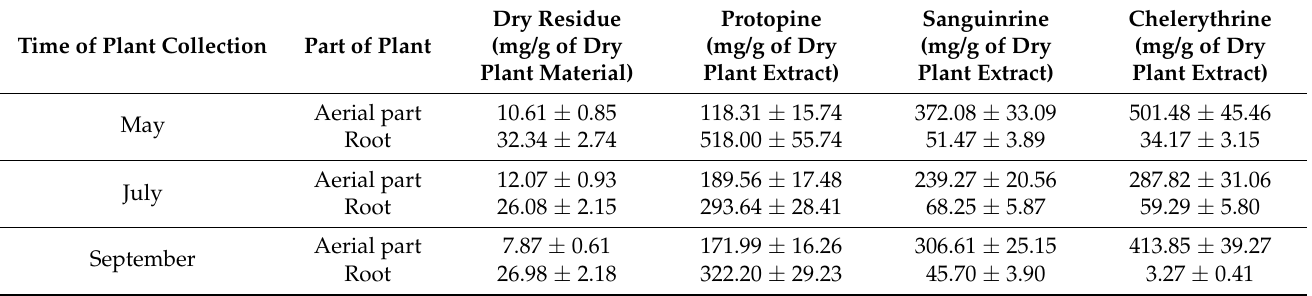
Table 2. Content of isoquinoline alkaloids in dry residue of plant extracts and standard deviation of these